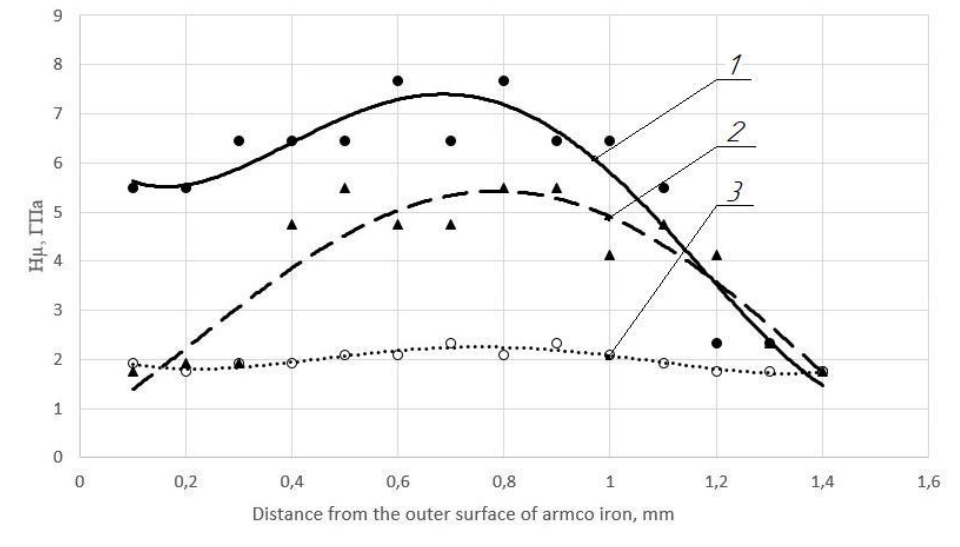
Fig. 5. Distribution of microhardness of the cross-section of the fusion nucleus of two steel plates: 1) in the presence of carbon nanofibers between them; 2) in the presence of carbon nanotubes and molybdenum powder between them 3) in the presence of molybdenum powder between